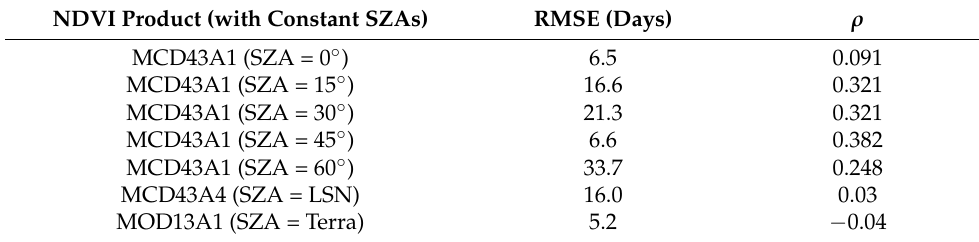
Table 4. Difference between the ground-observed and NDVI-derived EOS.